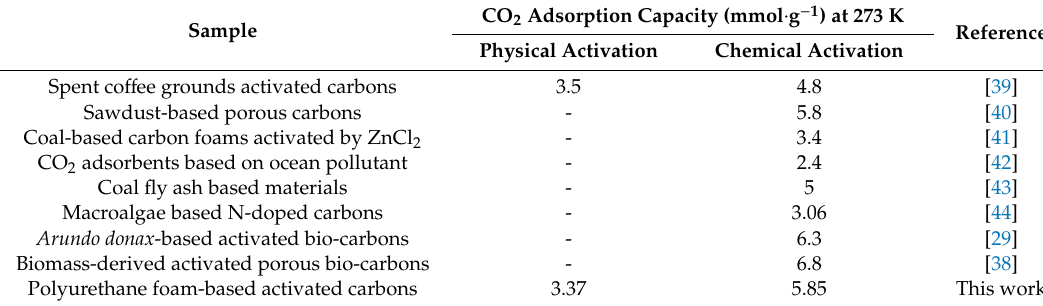
Table 3. CO 2 adsorption capacities at 273 K and 1 bar of activated carbons prepared from di ff erent